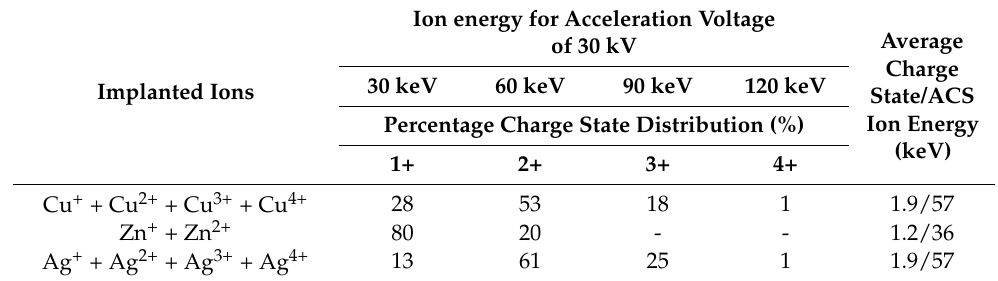
Table 1. The percentage charge state distribution and average charge state of several elements [29].